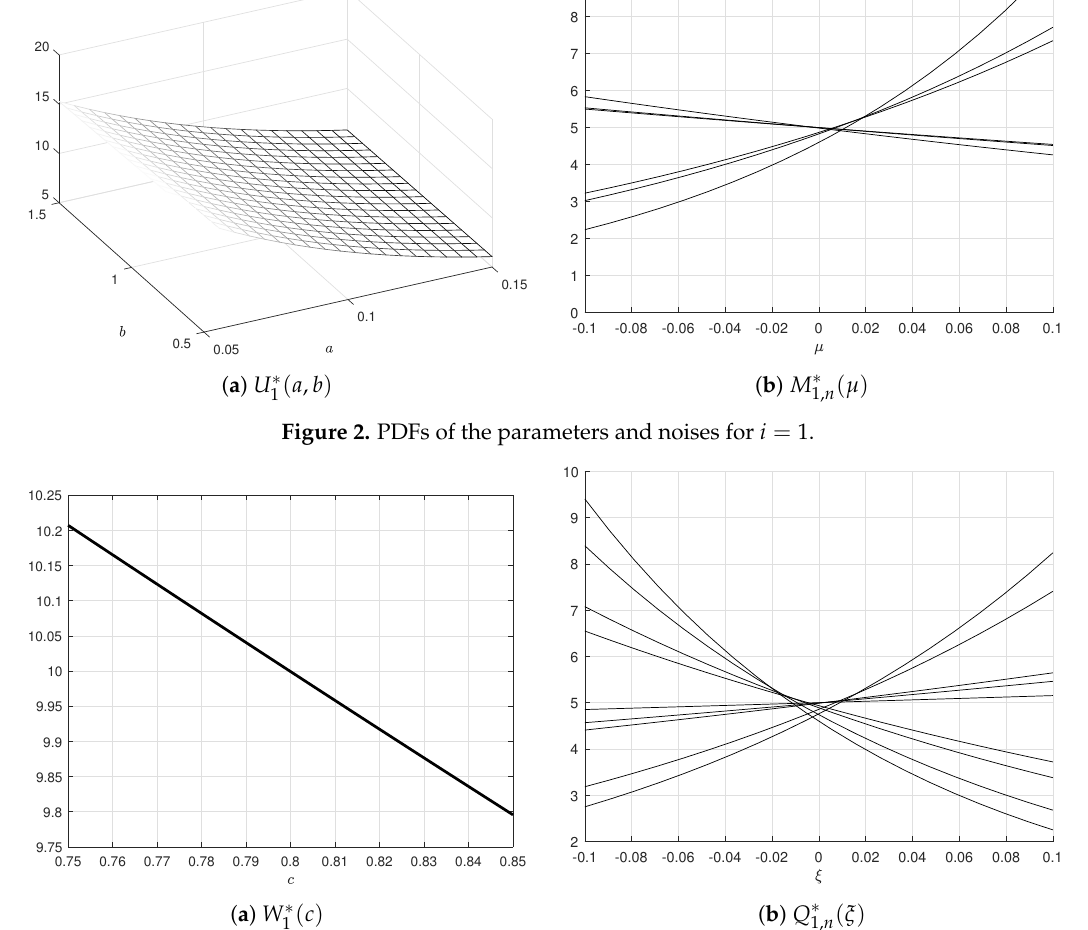
Figure 3. PDFs of the parameters and noises for i =